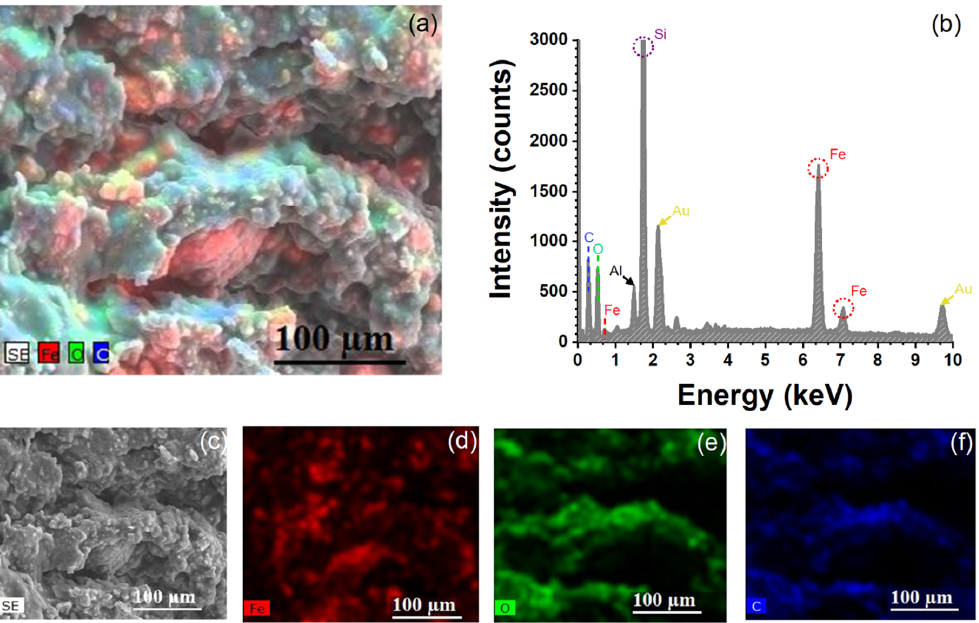
Figure 9. Elemental mapping of the Fe 3 O 4 iron oxide nanoparticles (IONPs) on PU–INU50. ( a ) Element (Fe + O + C) overlay distribution on the polyurethane, ( b ) complete electron dispersive spectroscopy (EDS) spectra of all elements distribution, ( c ) scanning electron microscopy (SEM) image and ( d – f ) element mapping of Fe (red), O (green), and C (blue).